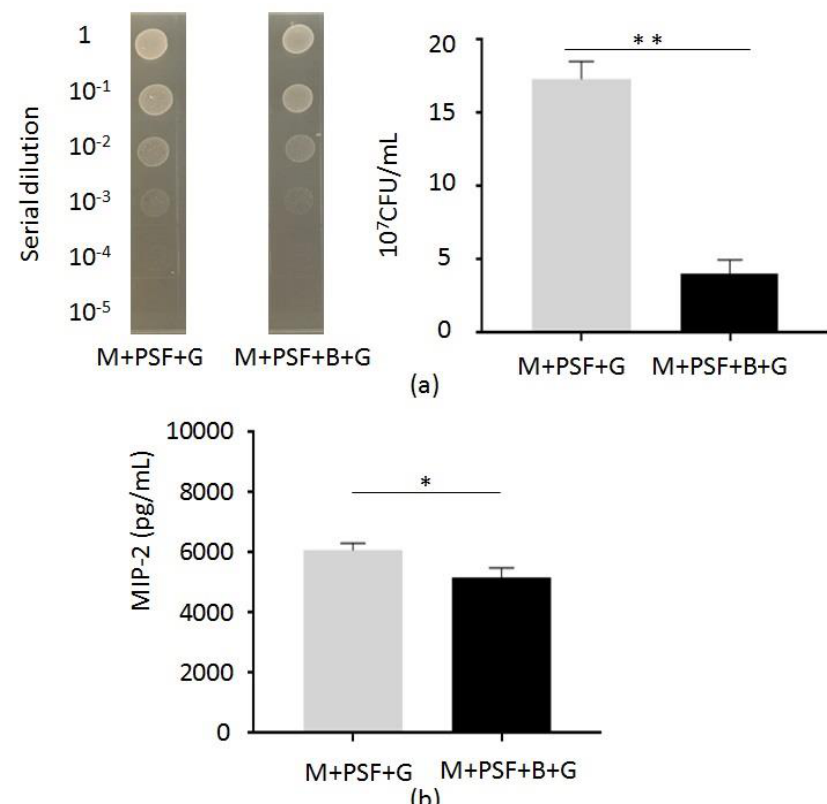
Figure 3. Reduction of C. acnes colonization and inflammation in vivo by glycerol fermentation of S. epidermidis in PSF MTAM. The ears of Institute for Cancer Research (ICR) mice were injected intradermally with C. acnes (ATCC 6919) (10 7 CFU) and topically applied with PSF MTAM loaded with (M+PSF+B+G) or without (M+PSF+G) S. epidermidis (ATCC 12228) (10 5 CFU) in the presence of